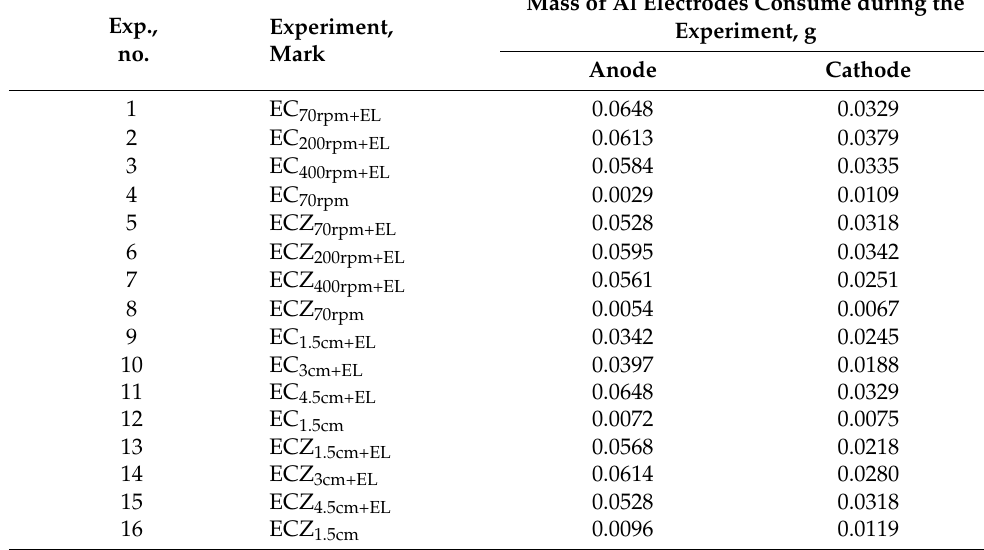
Table 5. Mass of Al electrodes consumed during the experiment.